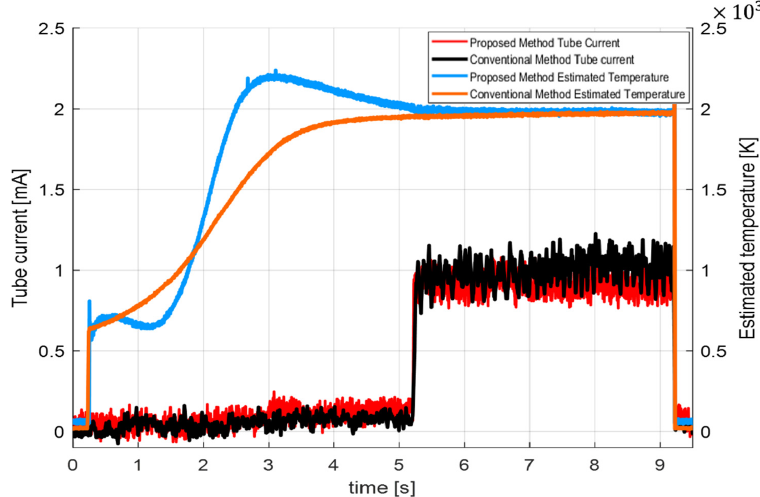
Figure 11. Comparison of the conventional and proposed methods at 1950 K.